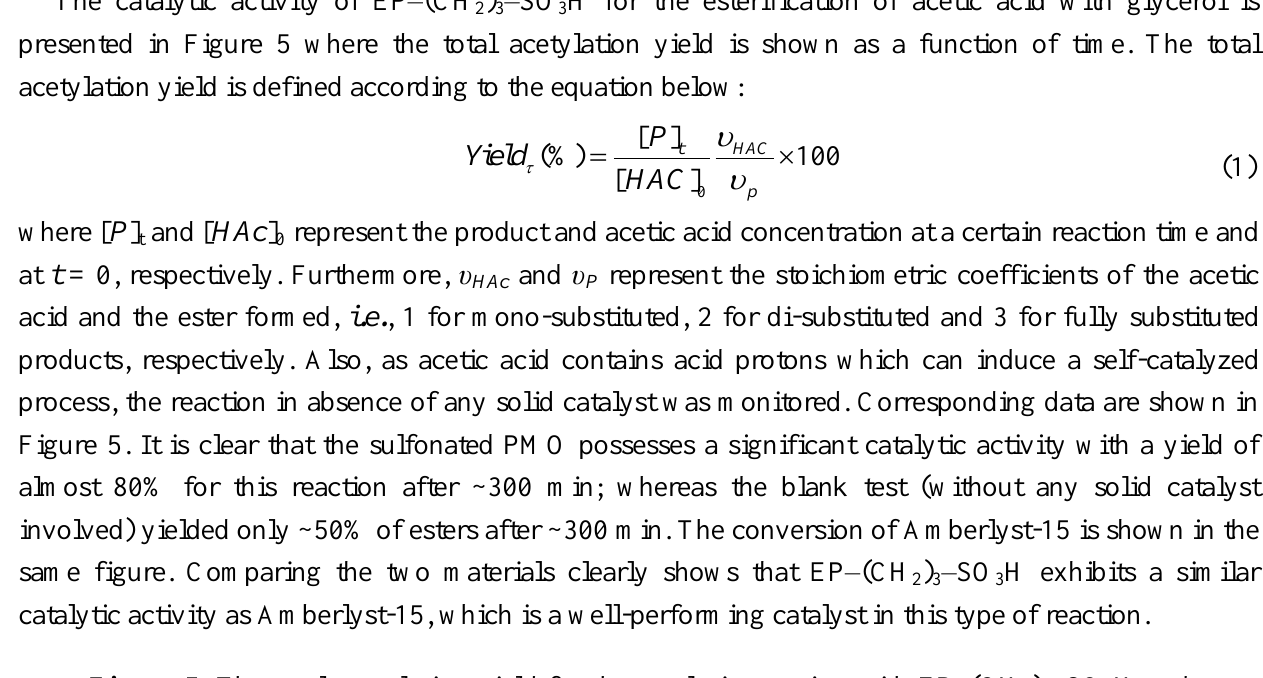
(Figure 4). Three products may in principle be obtained from this reaction: glycerol monoacetate (MAG), glycerol diacetate (DAG) and glycerol triacetate (TAG). However, experimentally, only MAG (~94%) and DAG (~6%) are formed using the specific catalytic conditions described in the experimental part [51].